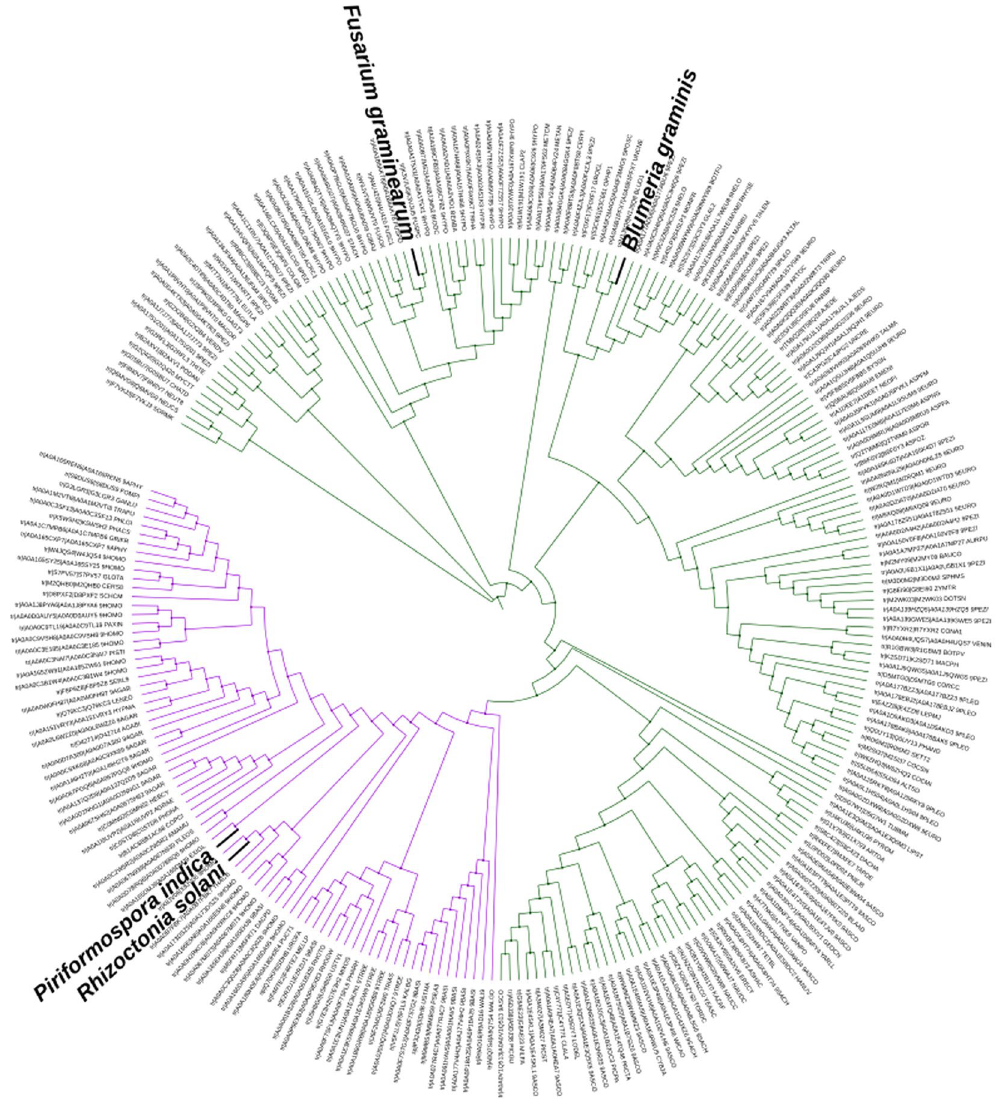
Figure 4. Phylogenetic analysis of SdhB homologs in Ascomycota and Basidiomycota. The phylogenetic tree was built using iTOL on the EMBL-EBI platform (http://itol.embl.de/), showing the evolutionary distance among SdhB homologs in Ascomycota and Basidiomycota. The Basidiomycota clade (represented by Piriformospora indica and Rhizoctonia solani ) is shown in purple, revealing significant divergence from the Ascomycota SdhB sequences (represented by Fusaium graminearum and Blumeria graminis f. sp. hordei ). The discrimination between SdhB homologs of Ascomycota and Basidiomycota provides a basis for the selective antifungal activity of Mtk in Ascomycota. For the list of sequences see the Supplementary